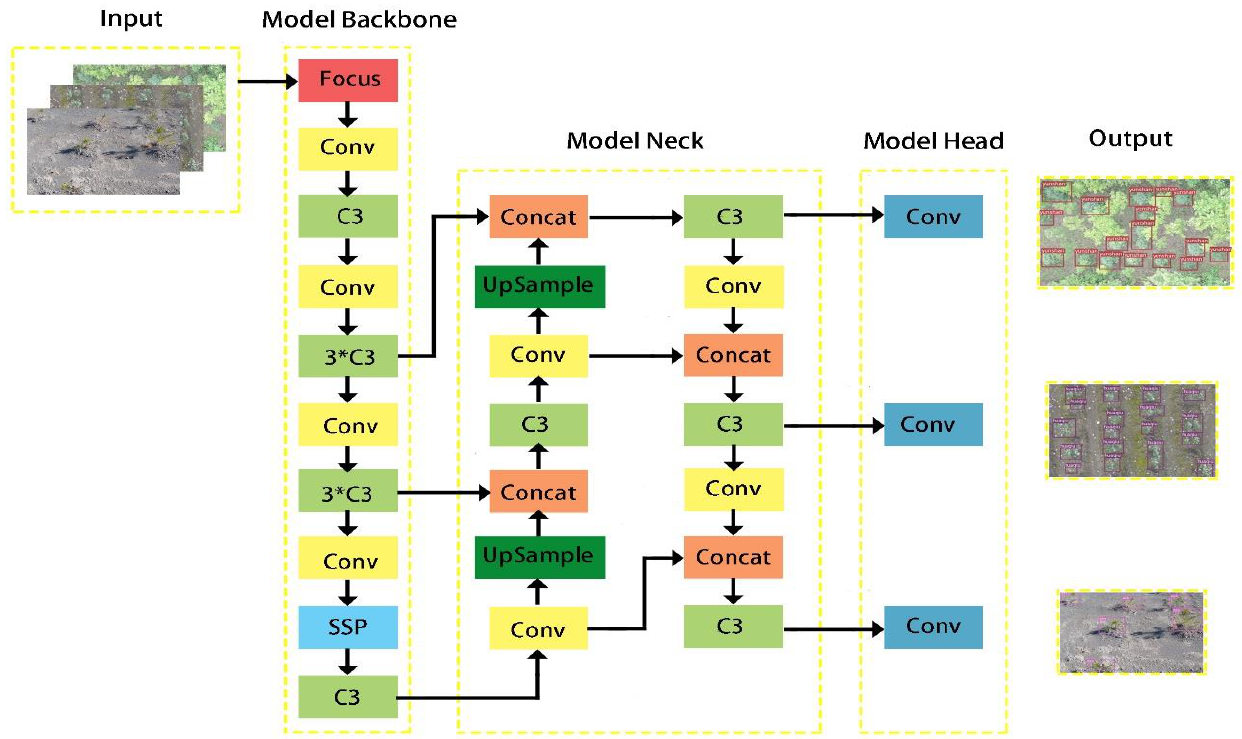
Figure 5. The structure of YOLOv5s.